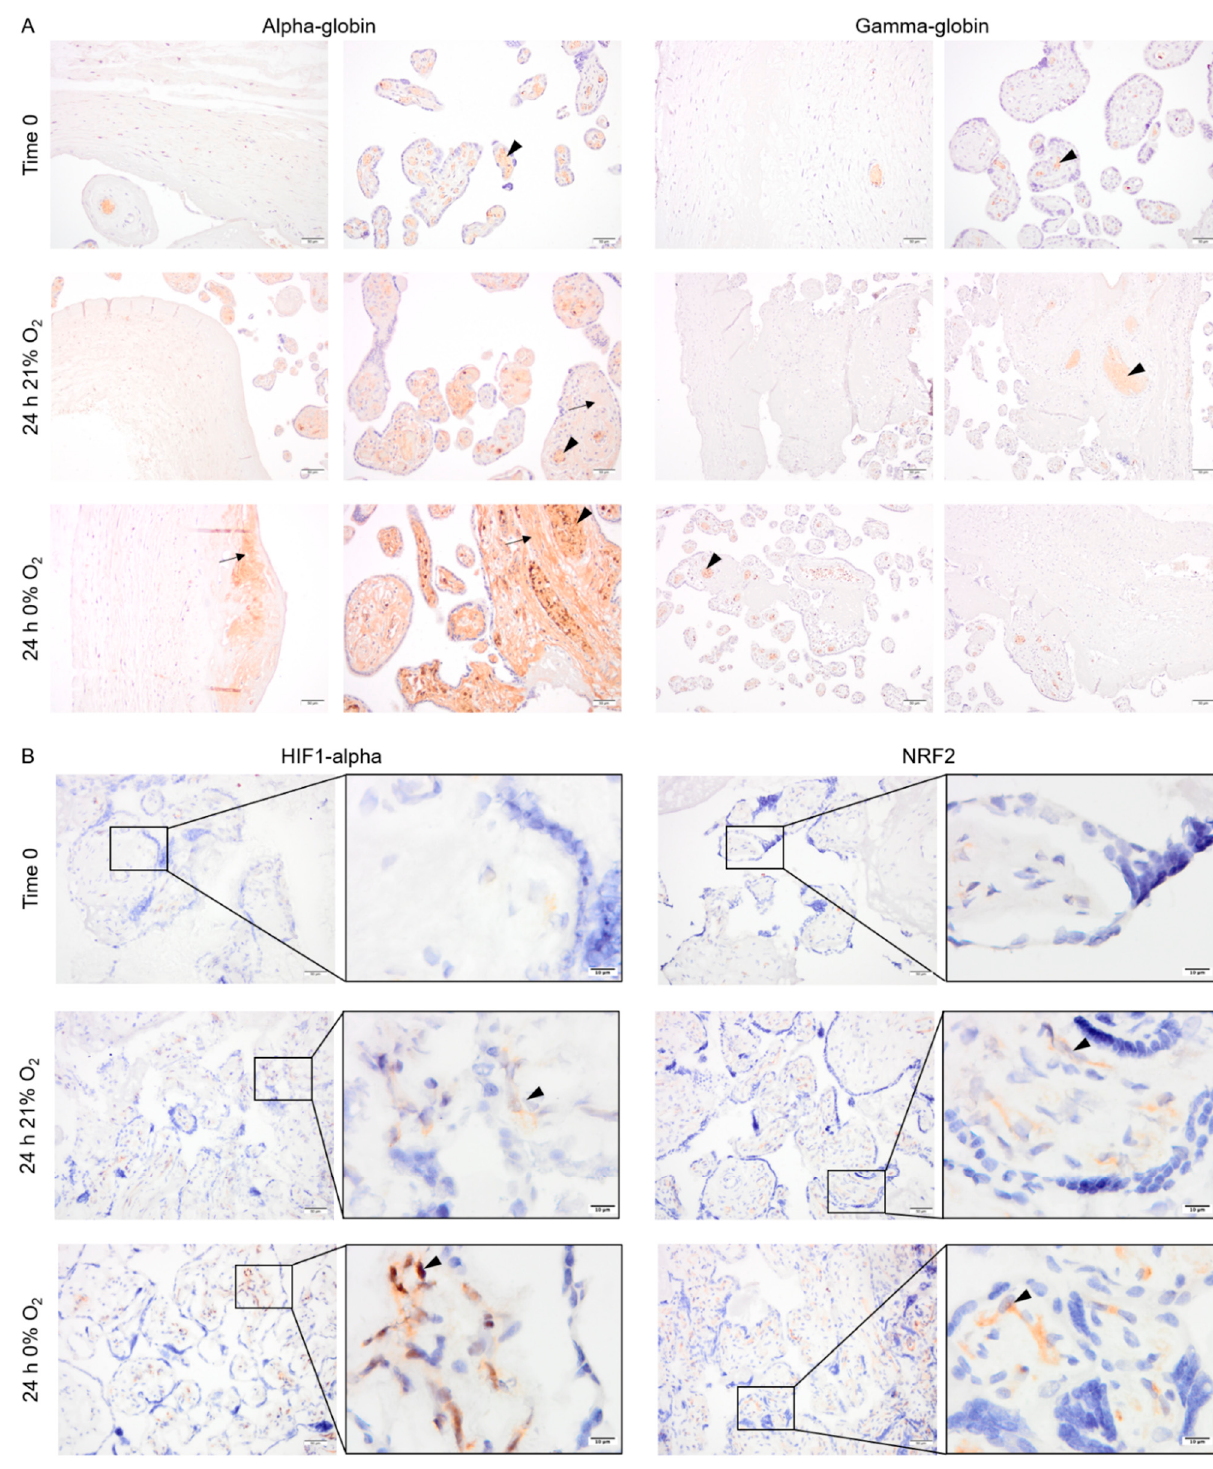
Figure 4. The pattern of expression of alpha- and gamma-globin as well as HIF1-alpha and NRF2 protein in placenta explants from normotensive pregnancies cultured in 0% or 21% oxygen. Alpha- and gamma-globin proteins were detected in erythrocytes (arrowhead) within the placenta vessels of explants cultured in 0% or 21% oxygen. Alpha-globin was also detected in villous stroma, particularly at 0% oxygen (arrow) ( A ). HIF1-alpha and NRF2 protein expression in placenta explants were detected in villous stroma, at both 0% and 21% oxygen levels (arrowhead). Scale bar is 50 µm in all images except for inserted higher magnifications in ( B ) where it is 10 µm. Negative control is presented in Figure S1.